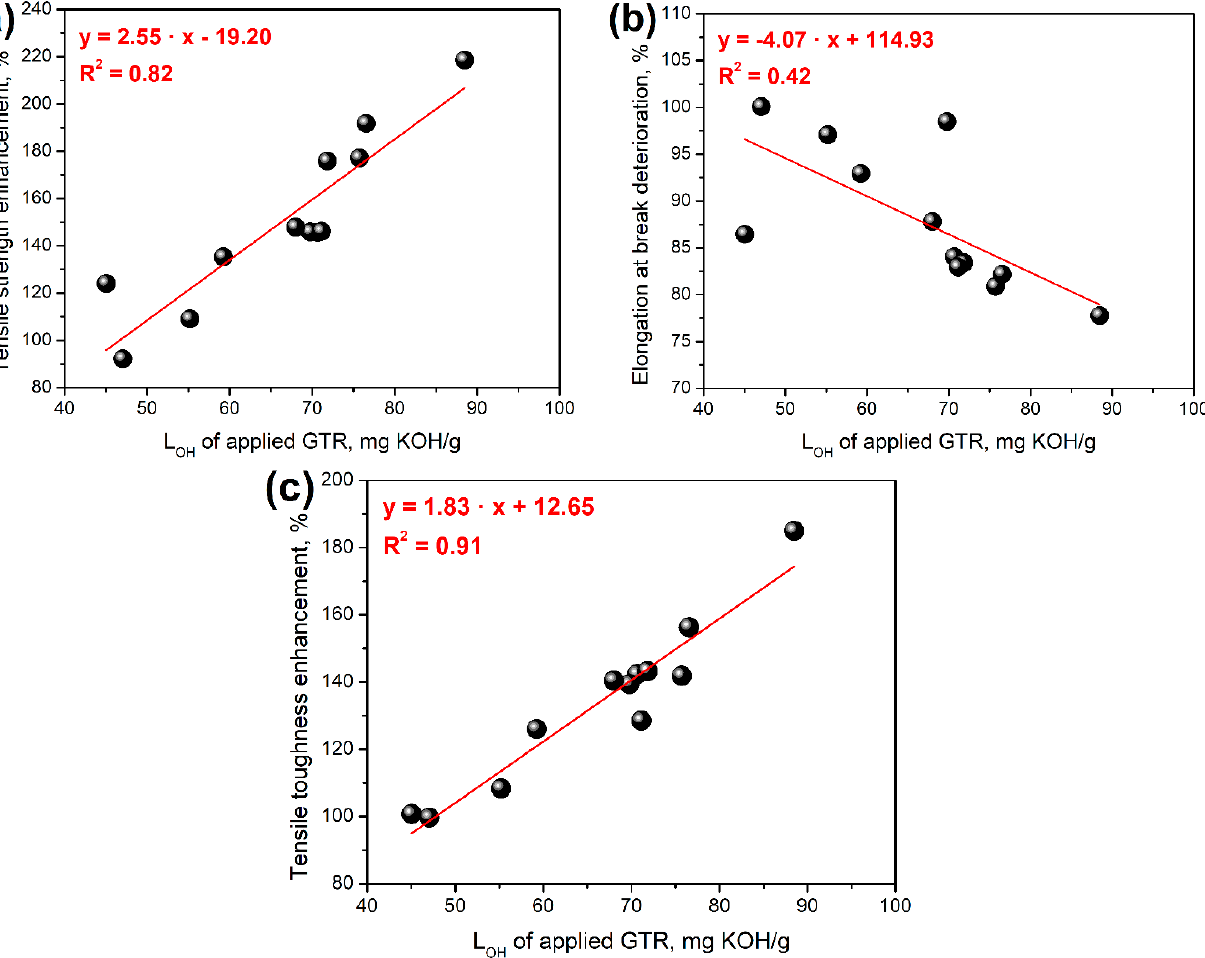
Figure 3. The impact of L OH of applied GTR on the ( a ) tensile strength enhancement, ( b ) elongation at break deterioration, and ( c ) tensile toughness enhancement of PU/GTR composite foams after formulation adjustments.